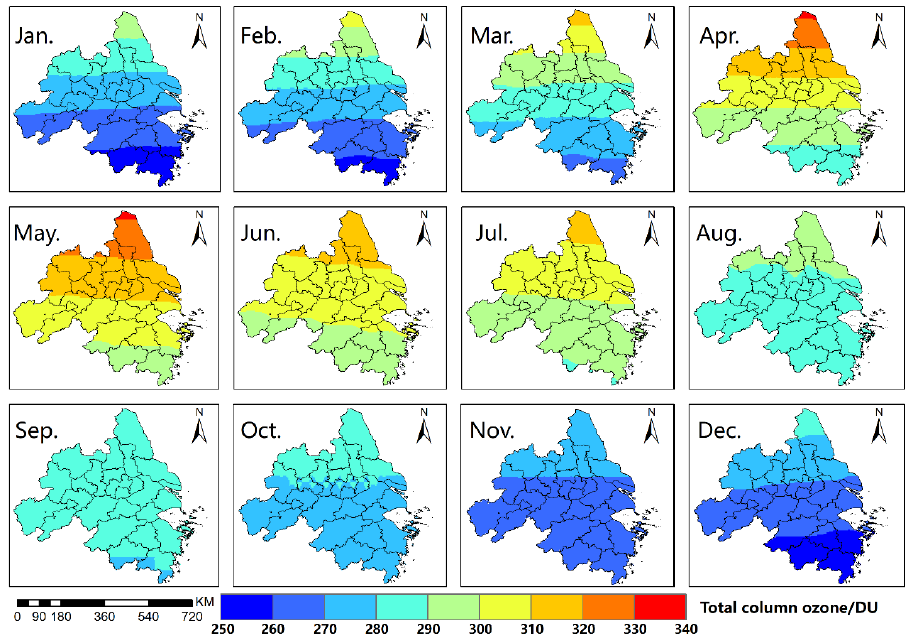
Figure A2. Spatial Distribution of Monthly the TCO over the Yangtze River Delta Urban Agglom- erations during 2000 – 2019. The monthly TCO distribution of Jan. is calculated by averaging the TCO in Jan. of the 20 years over the study area. The same progress was conducted on the other months in a year.